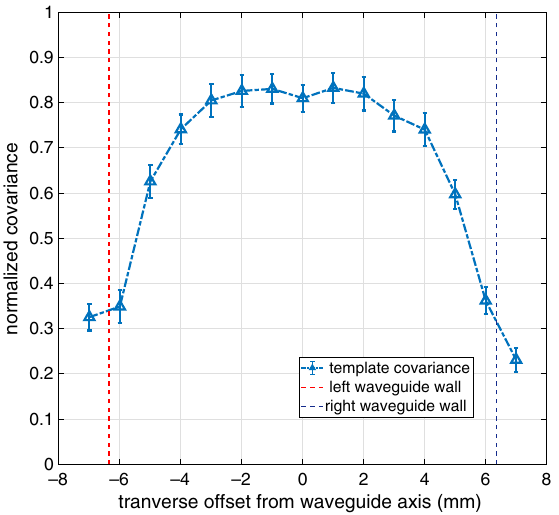
FIG. 13. Response function of the amplitude vs transverse offset from waveguide axis. The dashed curve shows the expected half-cosine